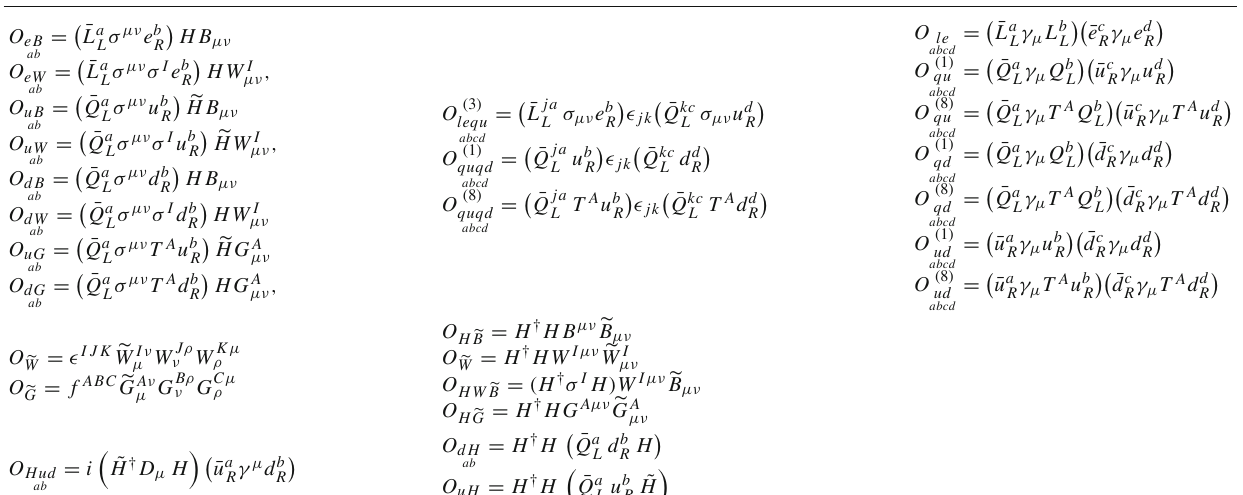
Table 1 Set of dimension-6 SMEFT operators relevant in this paper, grouped in six different boxes corresponding to the different classes discussed in the main text. The operators O typeoperatorscanonlybeprobedatthe1-looplevelthroughtheneutron EDM. The dashed line separates the 4-fermion operators of the form ψ 4 and those of the form ψ 2 ¯ ψ 2 . We use the usual definitions (cid:20) H = i σ 2 H ∗